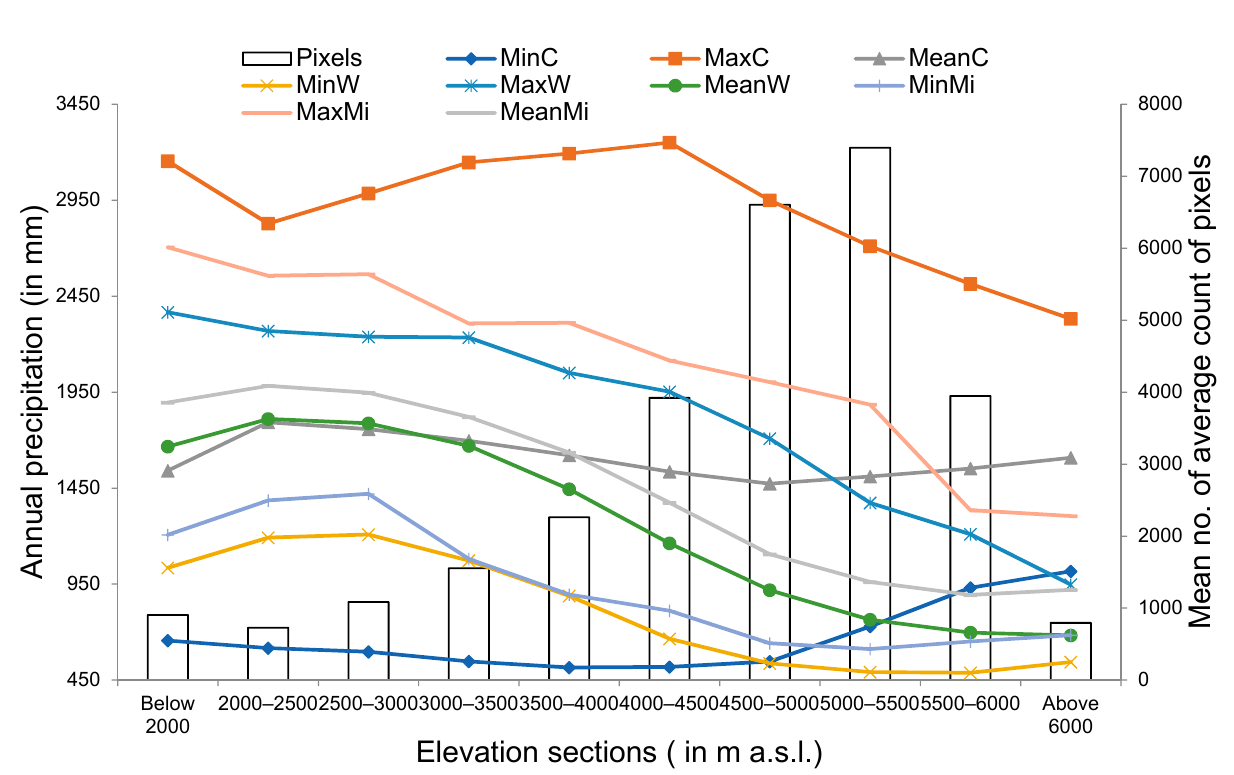
Figure 14. Curves represent minimum, maximum and mean values of annual precipitation obtained for each elevation section using WorldClim 2.0, CHELSA and MIROC climate dataset. Here, MinC, MaxC and Mean C represent minimum, maximum and mean values of annual precipitation obtained for each elevation section using CHELSA. Similarly, MinW, MaxW and MeanW represent minimum, maximum and mean values of annual precipitation obtained for each elevation section using WorldClim 2.0. Correspondingly, MinMi, MaxMi and MeanMi represent minimum, maximum and mean values of annual precipitation obtained for each elevation section using MIROC. Bars represent mean values of average count of pixels representing snow covered area for each elevation section obtained using MODIS observations. Table 2. Differences among MODIS land surface temperature observations and BIO1 values obtained from different climate data set. Here, MinC, MaxC and Mean C represent minimum, maximum and mean values of mean annual air temperature obtained for each elevation section using CHELSA. Similarly, MinW, MaxW and MeanW represent minimum, maximum and mean values of mean annual air temperature obtained for each elevation section using WorldClim 2.0. Correspondingly, MinM, MaxM and MeanM represent minimum, maximum and mean values of mean annual air temperature obtained for each elevation section using MODIS observations. In the same way, MinMi, MaxMi and MeanMi represent minimum, maximum and mean values of mean annual air temperature obtained for each elevation section using